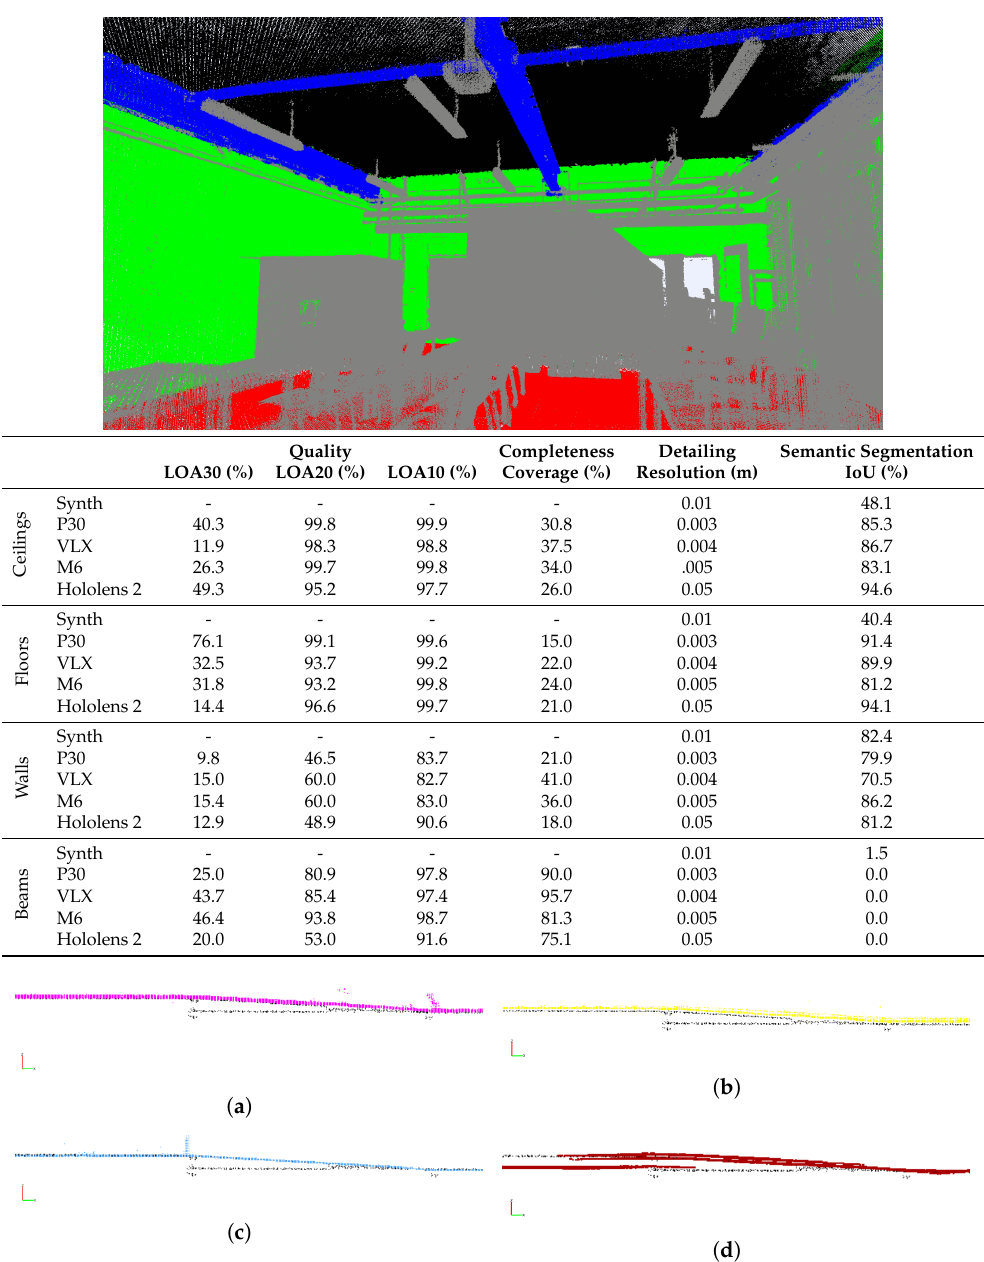
Figure 8. Alignment shortcomings: Sideview of the Hololens 2 misalignment with sloped floors due the assumptions in the SLAM algorithm (reference point cloud is shown in black). ( a ) VLX, ( b ) M6, ( c ) P30, and ( d ) Hololens